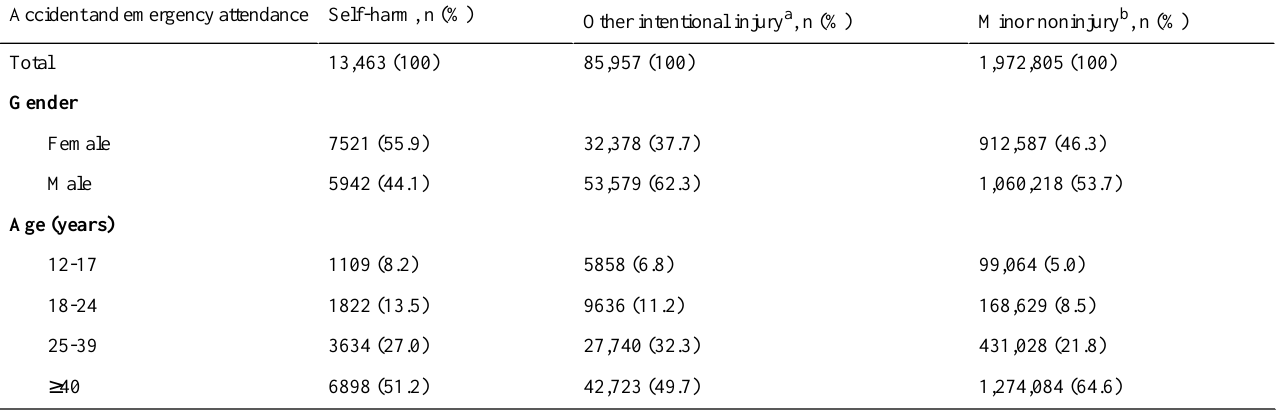
Table 1. Accident and emergency attendance in the observation period (from January 1, 2012 to July 31,